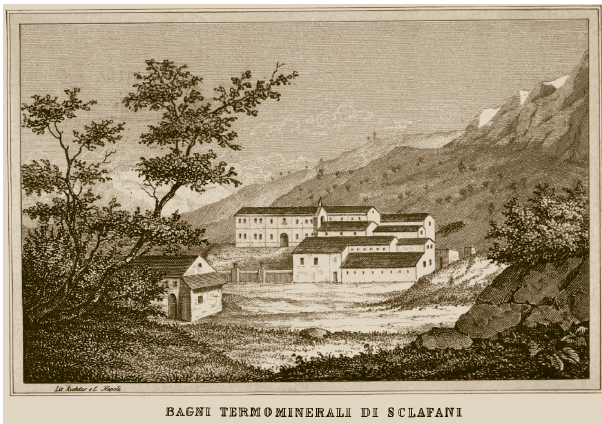
Figure 9. Anonymous, very detailed engraving of the ancient Sclafani spa (from Cappa, 1847, courtesy of the Faculty of Medicine Library, Complutense University of Madrid). Note in the fore- ground a rock block (linked to more ancient